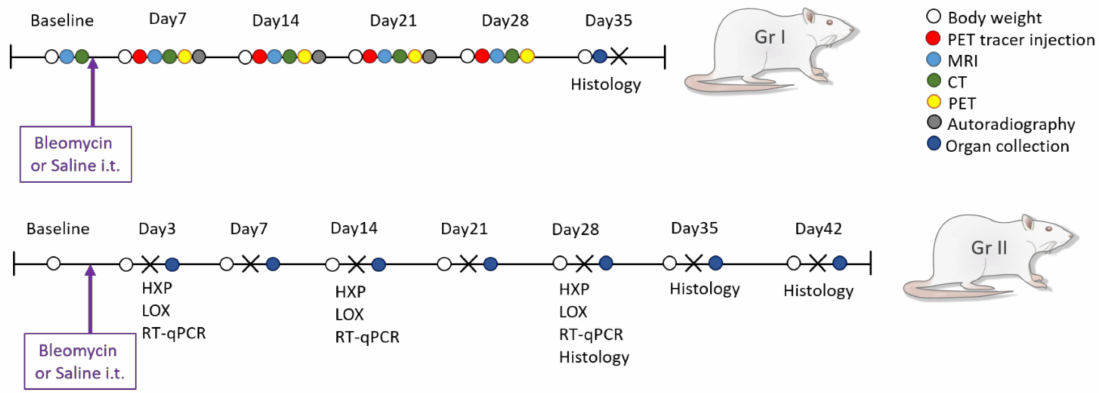
Figure 1. Study layout of bleomycin-induced lung injury and longitudinal imaging. Study layout with sampling and endpoints for the imaging group (Group I) and non-imaging group (Group II). Longitudinal imaging was done by combining MRI, CT, and PET in group I, while termination of 4–5 rats occurred every week, from Group II, for tissue sample collection and analysis of collagen content by hydroxyproline assay (HXP), lysyl oxidase (LOX) activity, gene expression analyses by RT-qPCR, and histological assessment by staining of lung tissue